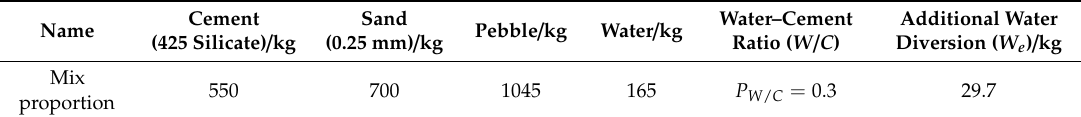
Table 2. Mix proportion of